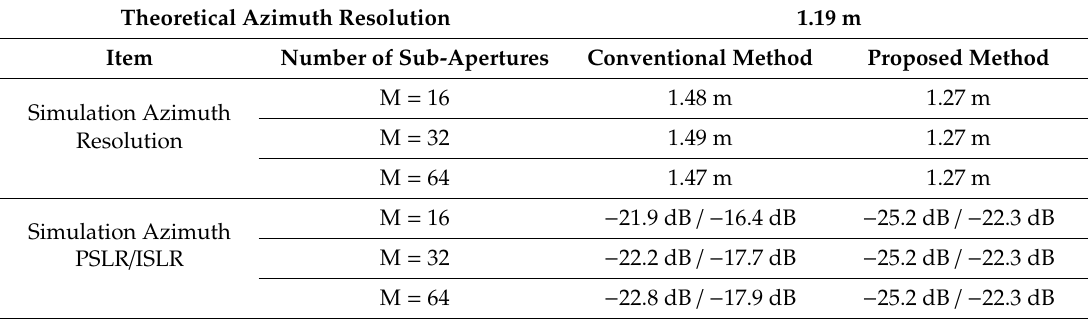
Table 2. Evaluation results of point targets simulation.